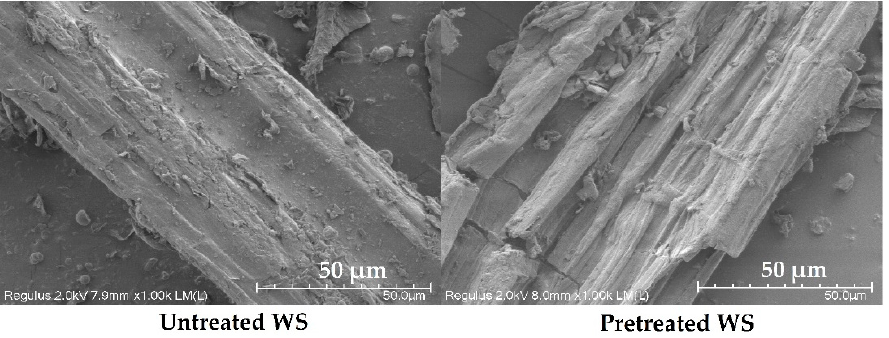
Figure 9. SEM pictures of untreated WS and pretreated WS using DES at 120